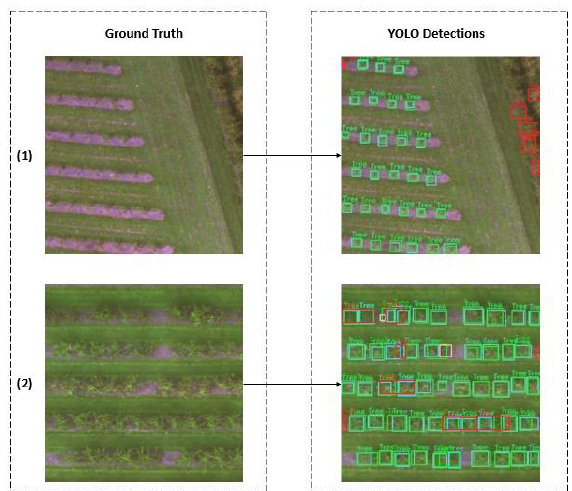
Figure 12. Comparison between the manually detected and YOLO-based trees on the RGB patches. Red rectangles correspond to false detections (FP), purple rectangles correspond to YOLO missed detections (FN), blue rectangles correspond to correctly detected trees